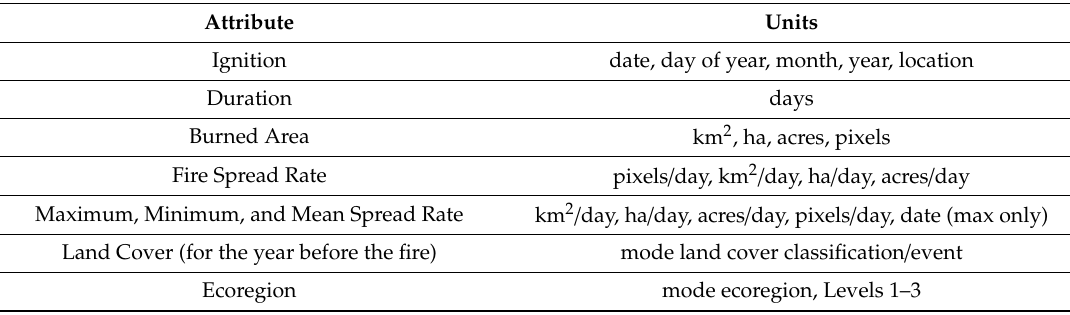
Table 3. Attributes included in the event-level FIRED product.